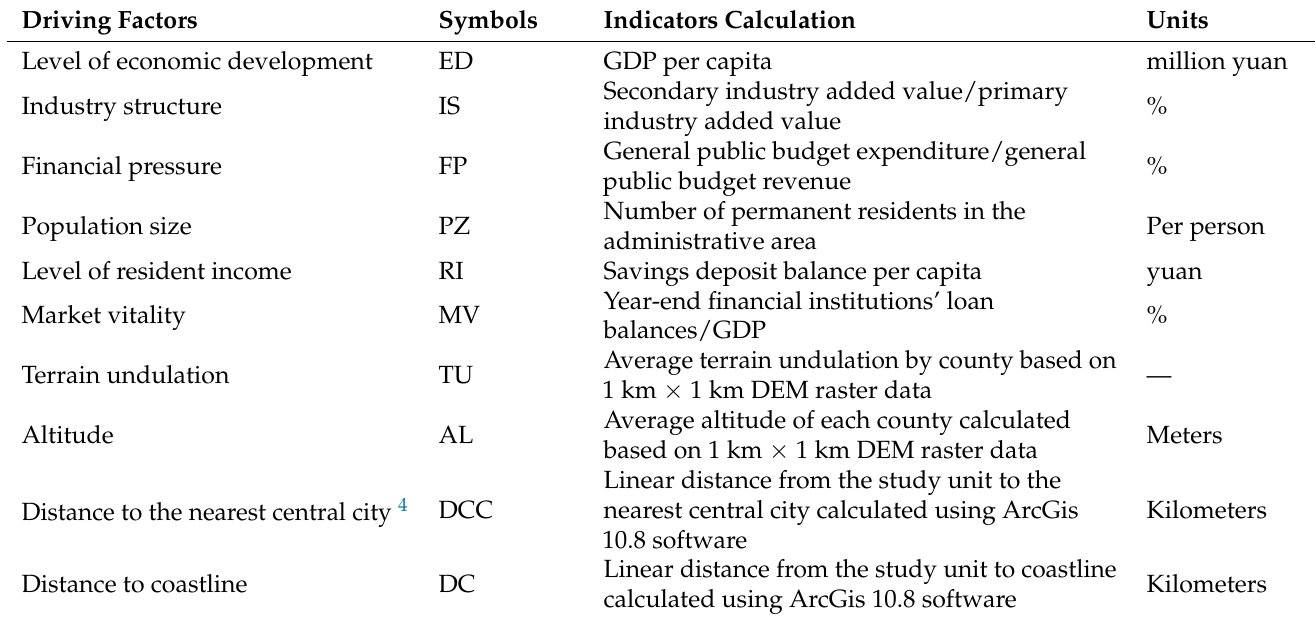
Table 2. County sprawl drivers and their indicator